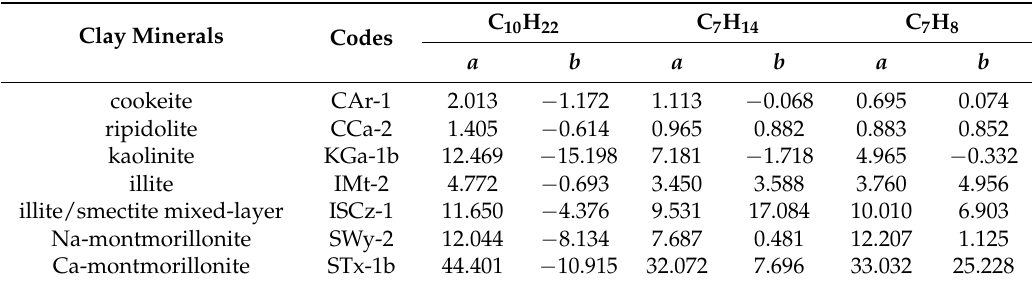
Table 3. Fitting parameters a and b for C 10 H 22 , C 7 H 14 and C 7 H 8